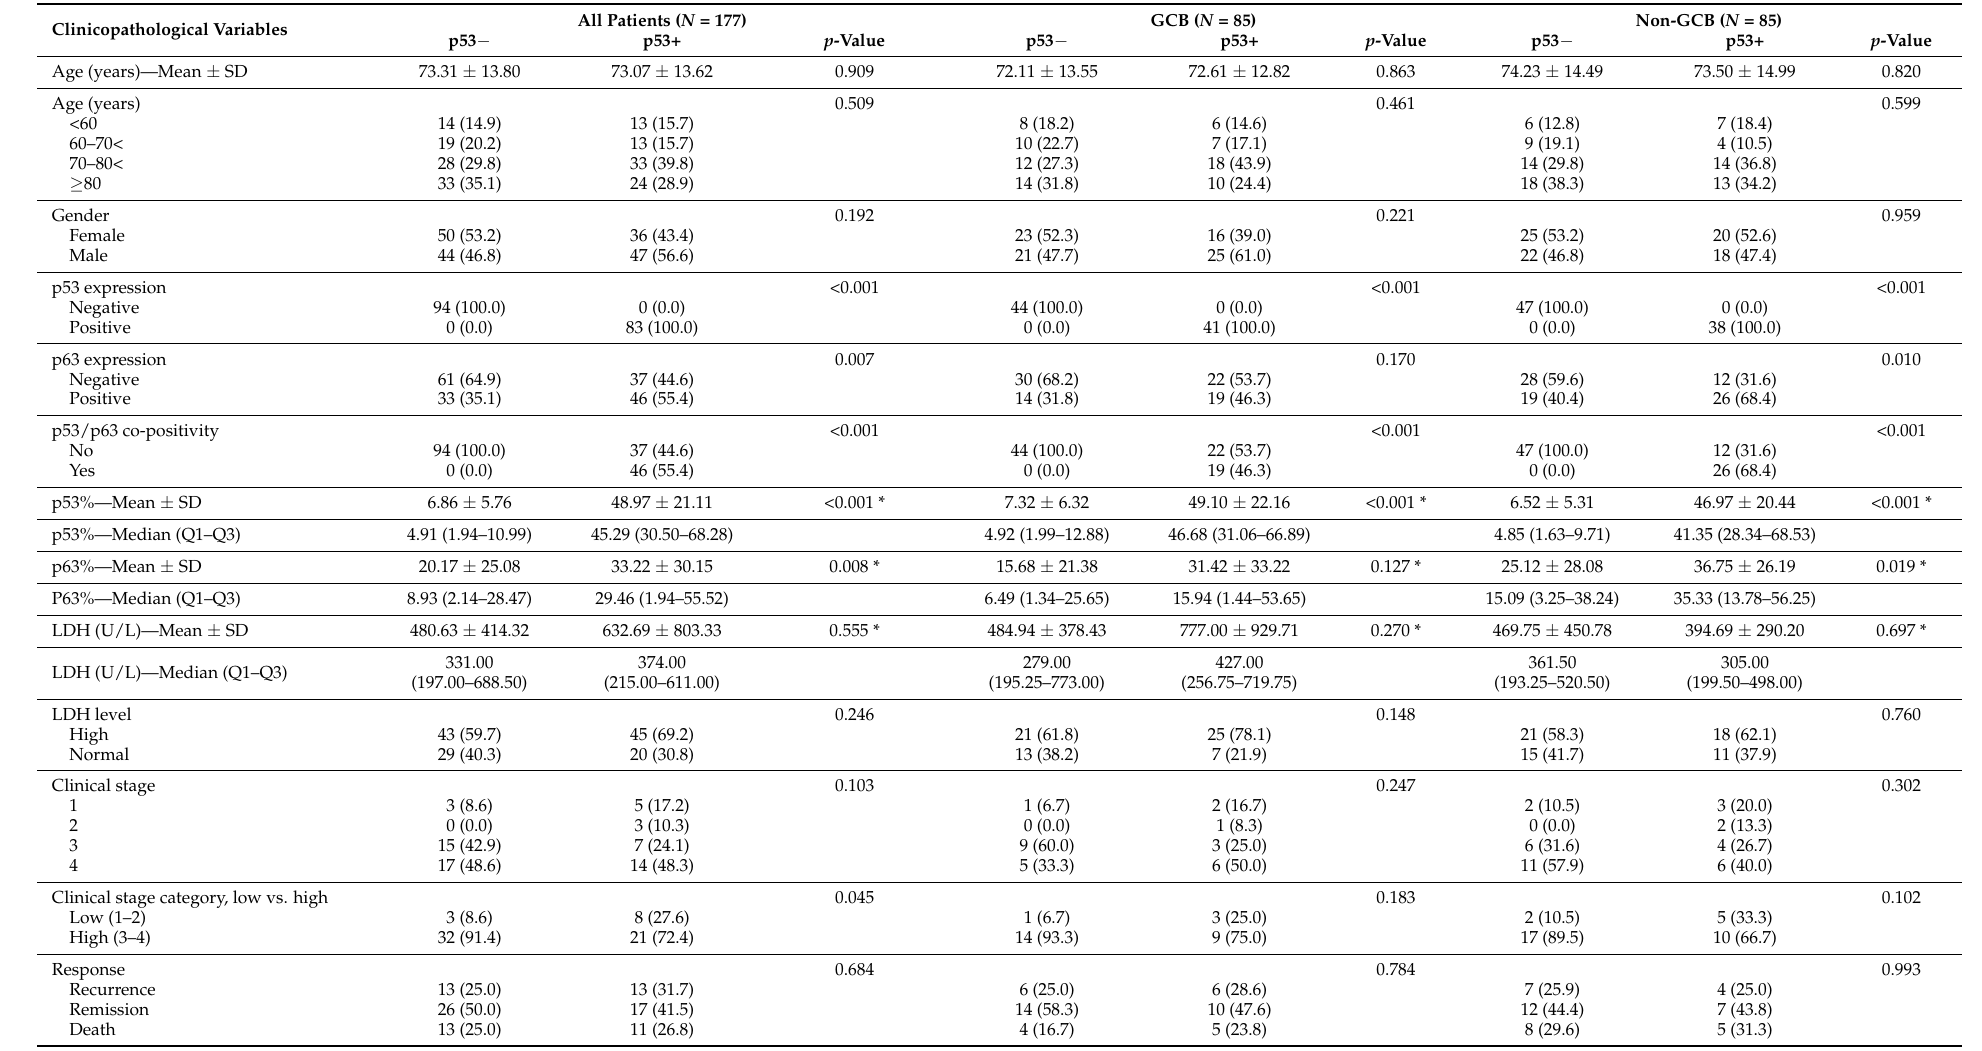
Table 5. Correlation between p53 positivity and clinicopathological characteristics of patients stratified into GCB and non-GCB subgroups ( N =